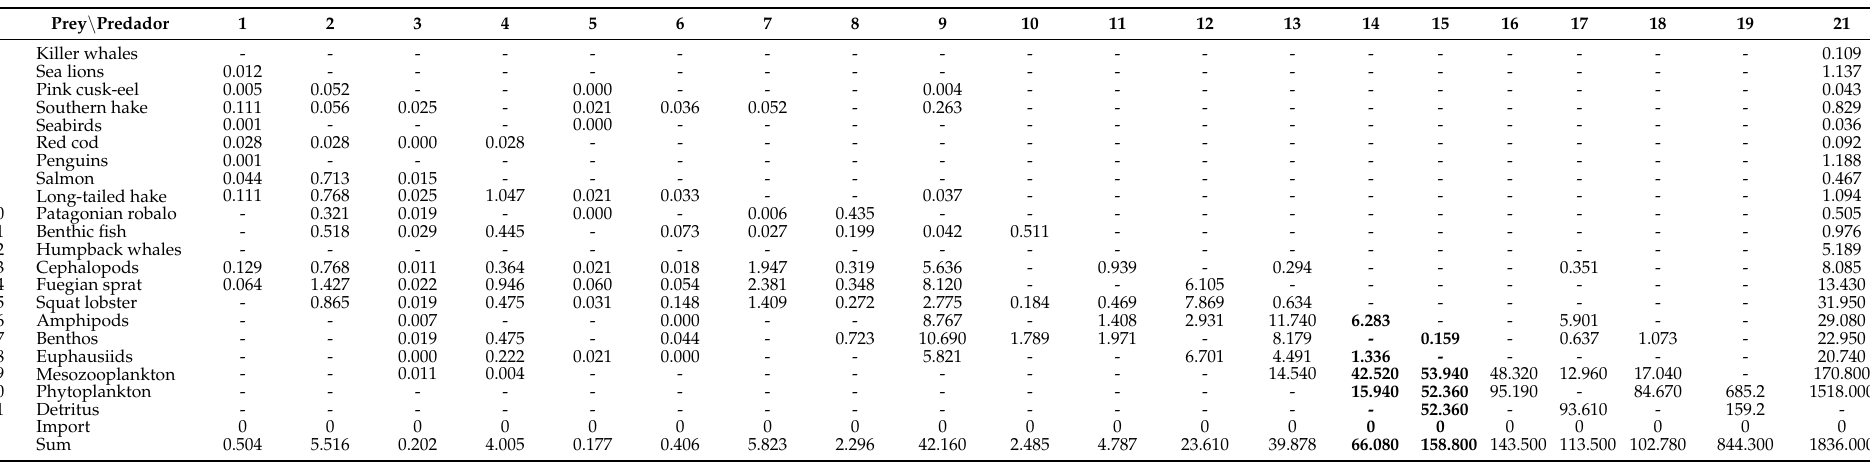
Table 2. Consumption matrix of functional groups of the Francisco Coloane Marine Area ecosystem. Consumptions of squat lobster and Fuegian sprats are shown in